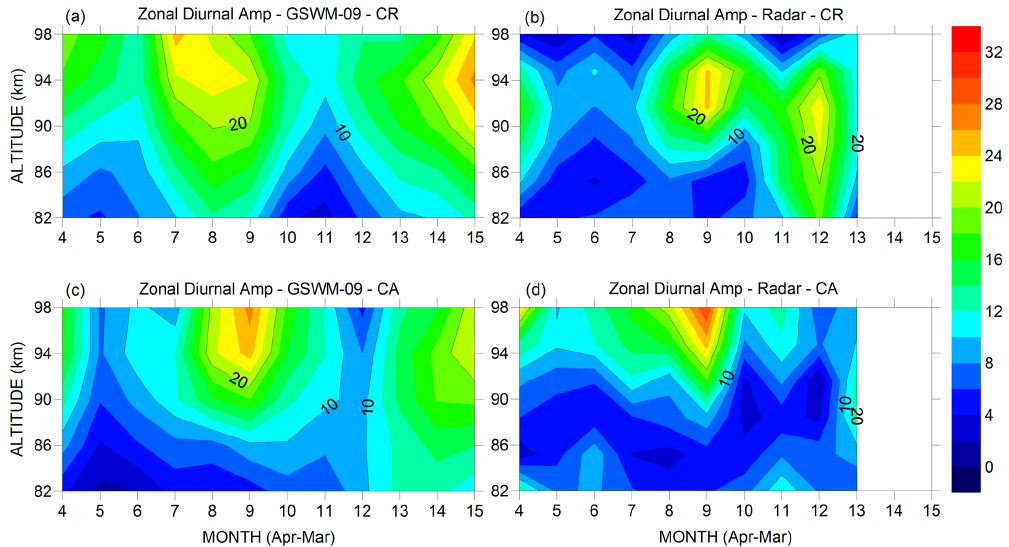
Figure 2. Panels (a) and (c) show diurnal zonal amplitudes as predicted by GSWM-09 model in the range between 82 and 102km height from April to March in CR and CA. Panels (b) and (d) show diurnal zonal amplitudes observed by radar in CR and CA in the same range from April 2005 to January 2006. The color scale represents the amplitude in meters per second